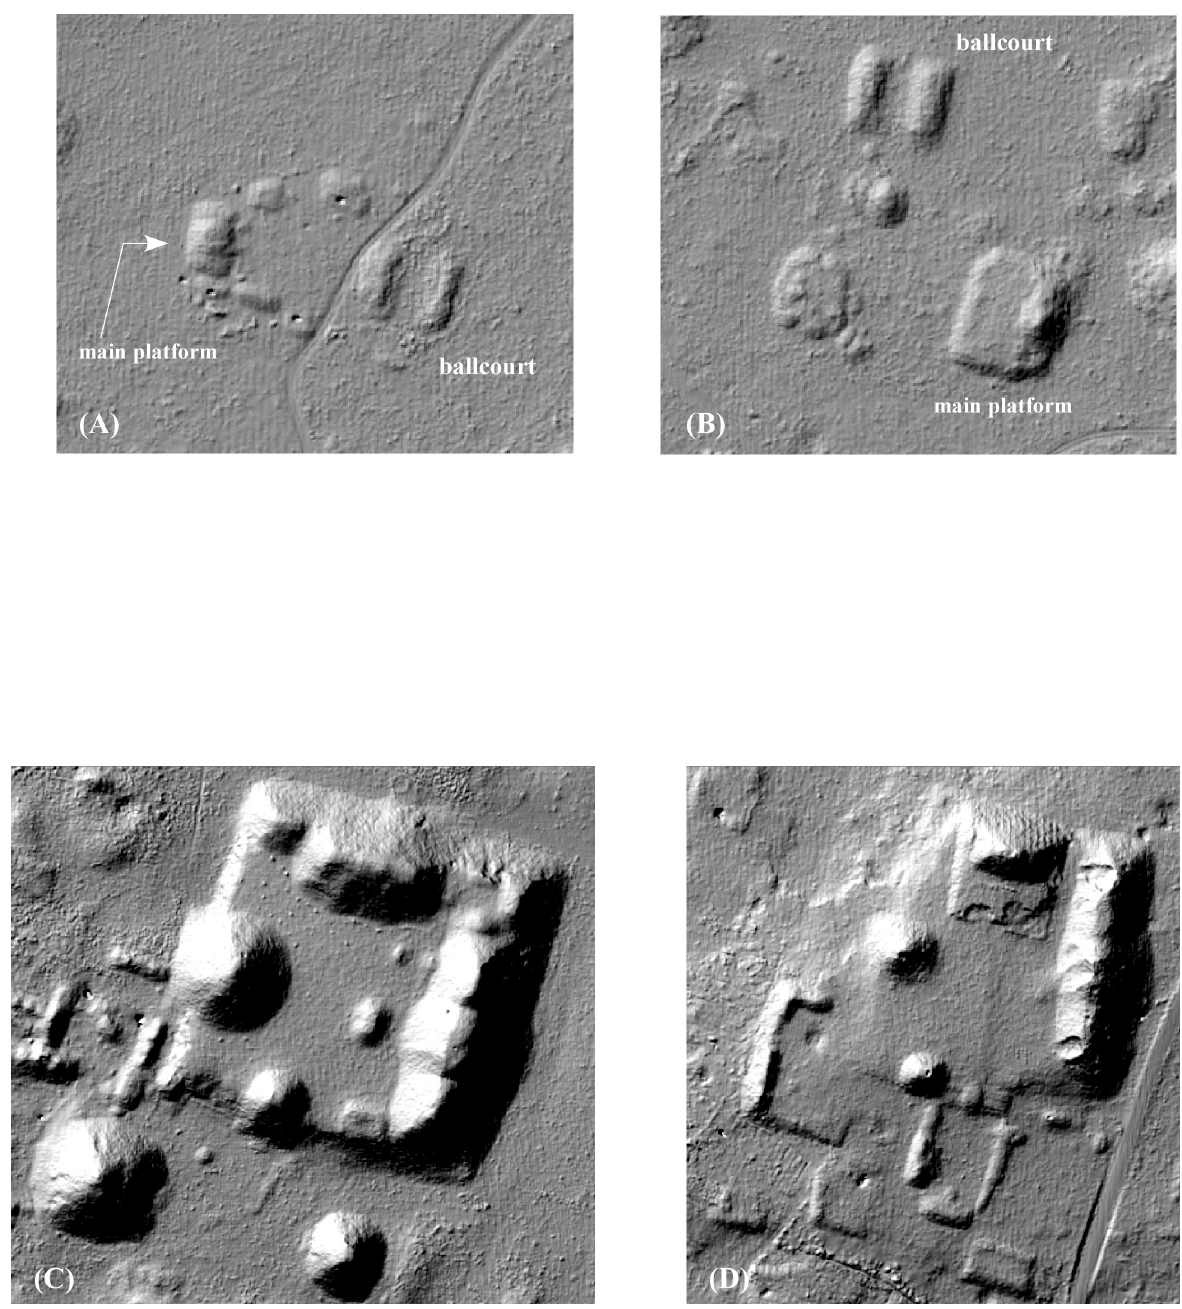
Fig 13. Middle Preclassic civic structures. (A) Paso del Macho, (B) a similar center near UTM N2233300E231700, Zone 16N, (C) the Yaxhom acropolis, (D) the Muluchtzekel acropolis. See also Fig 16B. All are to a common scale.